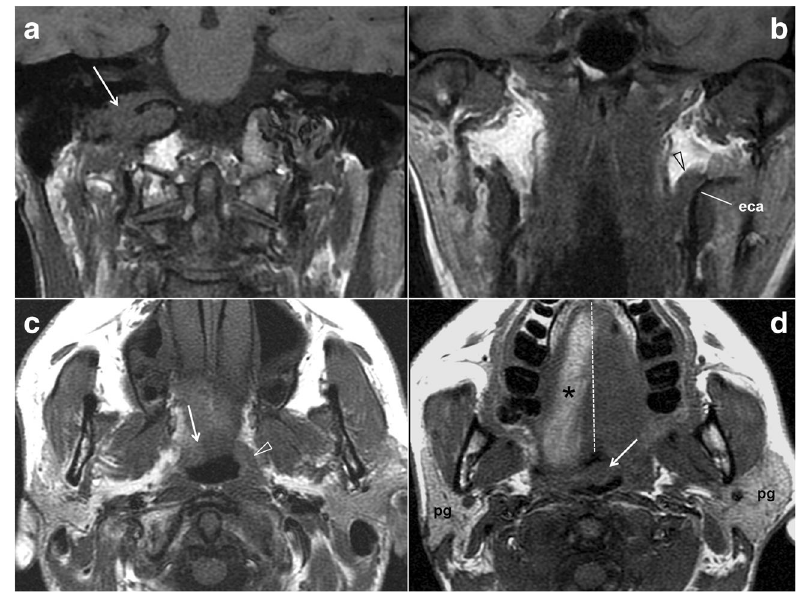
Fig. 12 Glossopharyngeal nerve dysfunction. Low cranial nerves palsy. a Coronal fast spin-echo T1-weighted MRI of the neck. A slightly hypointense mass eroding the right jugular foramen (arrow) was demonstrated to be a glomus jugulare paraganglioma. b Coronal fast spin-echo T1-weighted MRI of the neck. The normal stylopharyngeus muscle (arrowhead) on the left and its relationship with the external carotid artery (eca) help to recognise the muscle atrophy on the right side. Stylopharyngeus muscle atrophy is one of the few specific imaging signs of glossopharyngeal nerve dysfunction. c Axial fast spin-echo T1- weighted MRI of the neck. An asymmetric oropharyngeal lumen due to a